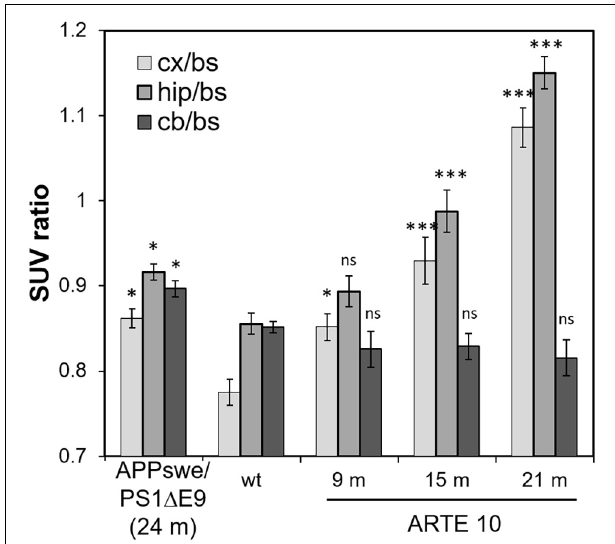
FIGURE 4 | Comparison of FBB retention in the brains of ARTE10 and APPswe/PS1 (cid:49) E9 mice. For comparison of both mouse lines, FBB retention was quantified in the cortex (cx), hippocampus (hip), and cerebellum (cb) with brain stem (bs) as reference region and expressed as SUVR. Data are expressed as mean ± SEM; ns, not significant, * p < 0.05, *** p < 0.0001 vs. wild-type